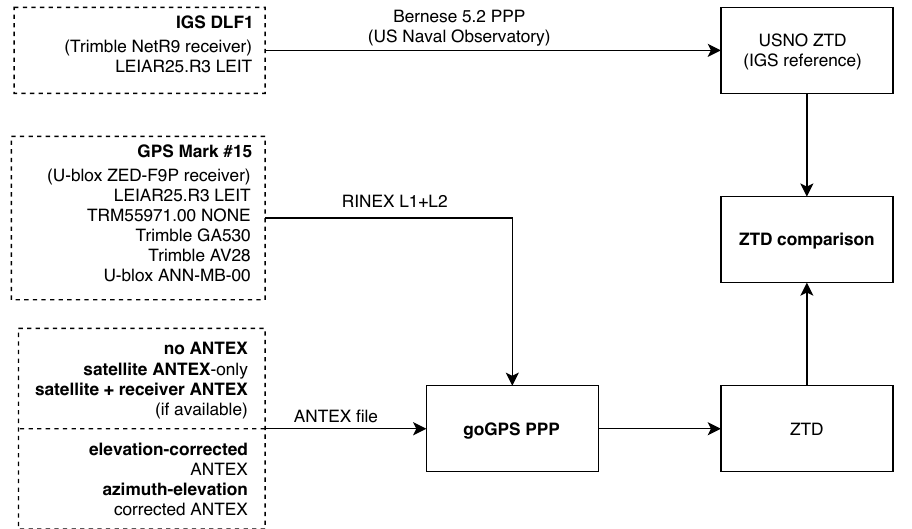
Figure 3. PPP ZTD evaluation concept. Original dual-frequency RINEX files are utilized as file input. Several runs with different antennas and ANTEX configurations are tested. The absolute